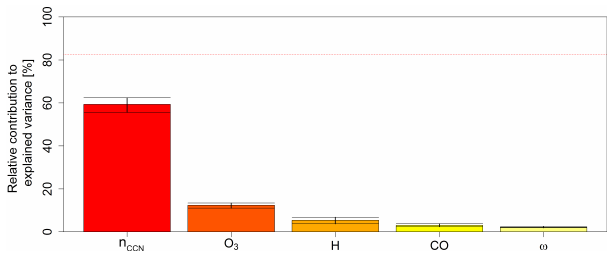
Figure 14. The contribution of each of the model variables in Eq. (5) to the explained variance. The error bars show the spread of the variation of the contribution values in the random samples from Fig.